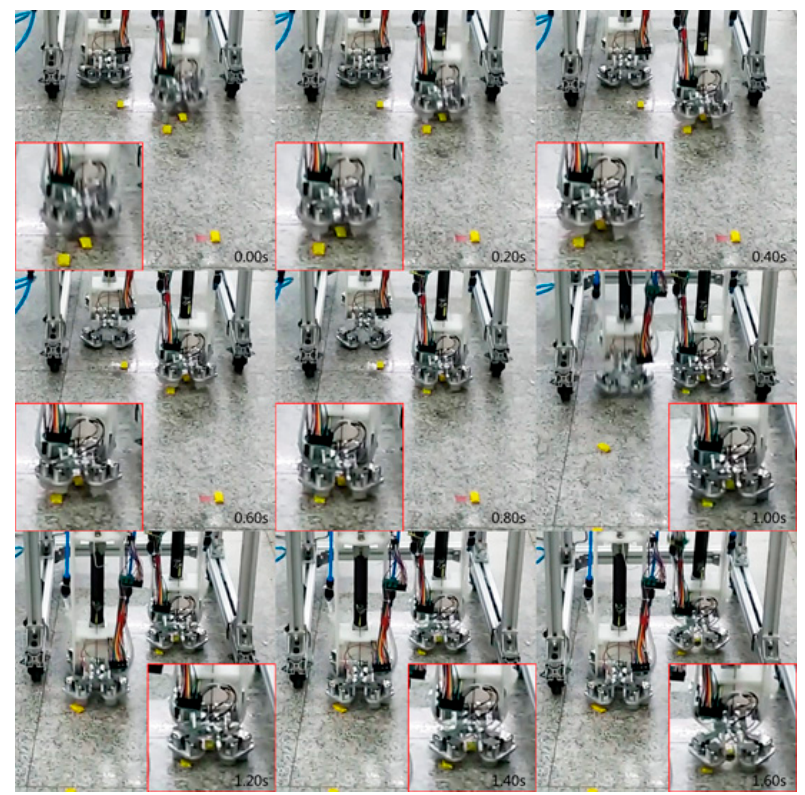
Figure 15. Screenshots of the new foot contacting with the bumps on the ground during walking.